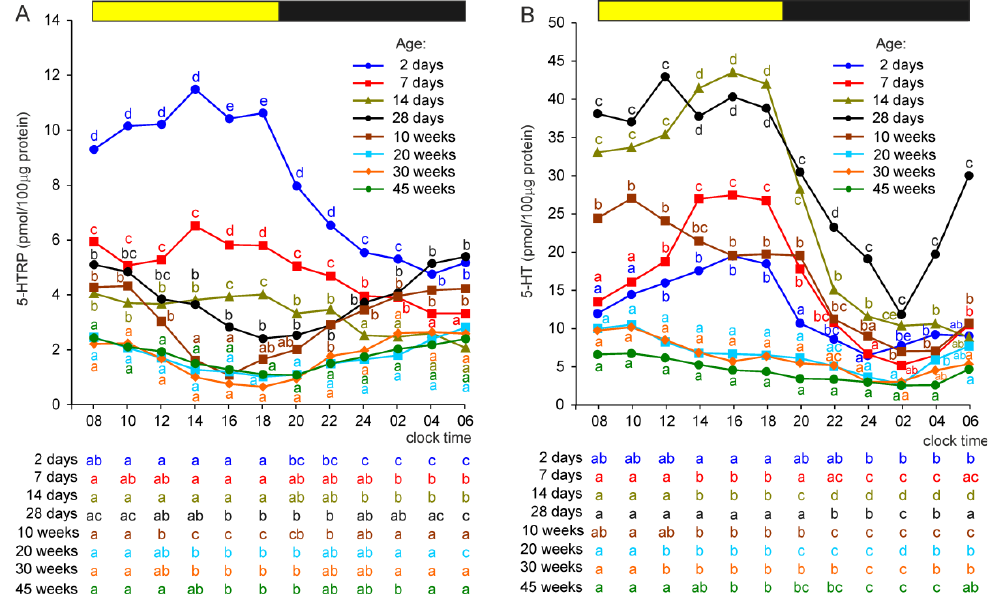
Figure 3. Concentrations (means) of 5-hydroxytryptophan, 5-HTRP ( A ), and serotonin, 5-HT ( B ), in the pineal organs of turkeys at the ages of 2, 7, 14, 28 days and 10, 20, 30, 45 weeks. The horizontal bar represents the periods of light and dark phases of the daily cycle. The letters on the charts show differences between age groups at each time-point in Duncan’s test. The letters below the charts show differences between time-points within a group in Duncan’s test. The same letters indicate means which are not significantly different.